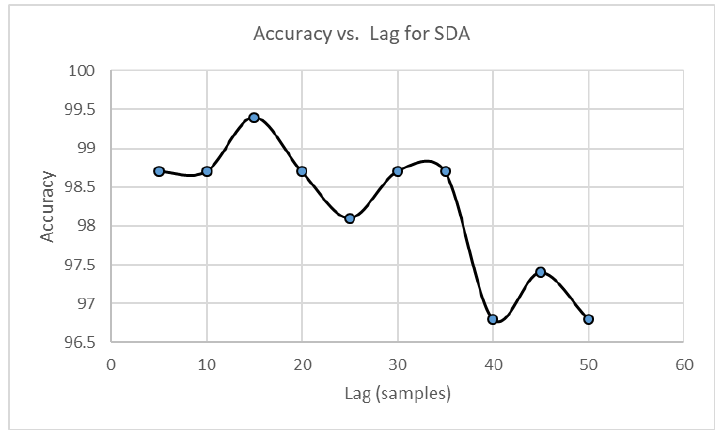
Figure 20. Accuracy according to Lag = τ for SD features.